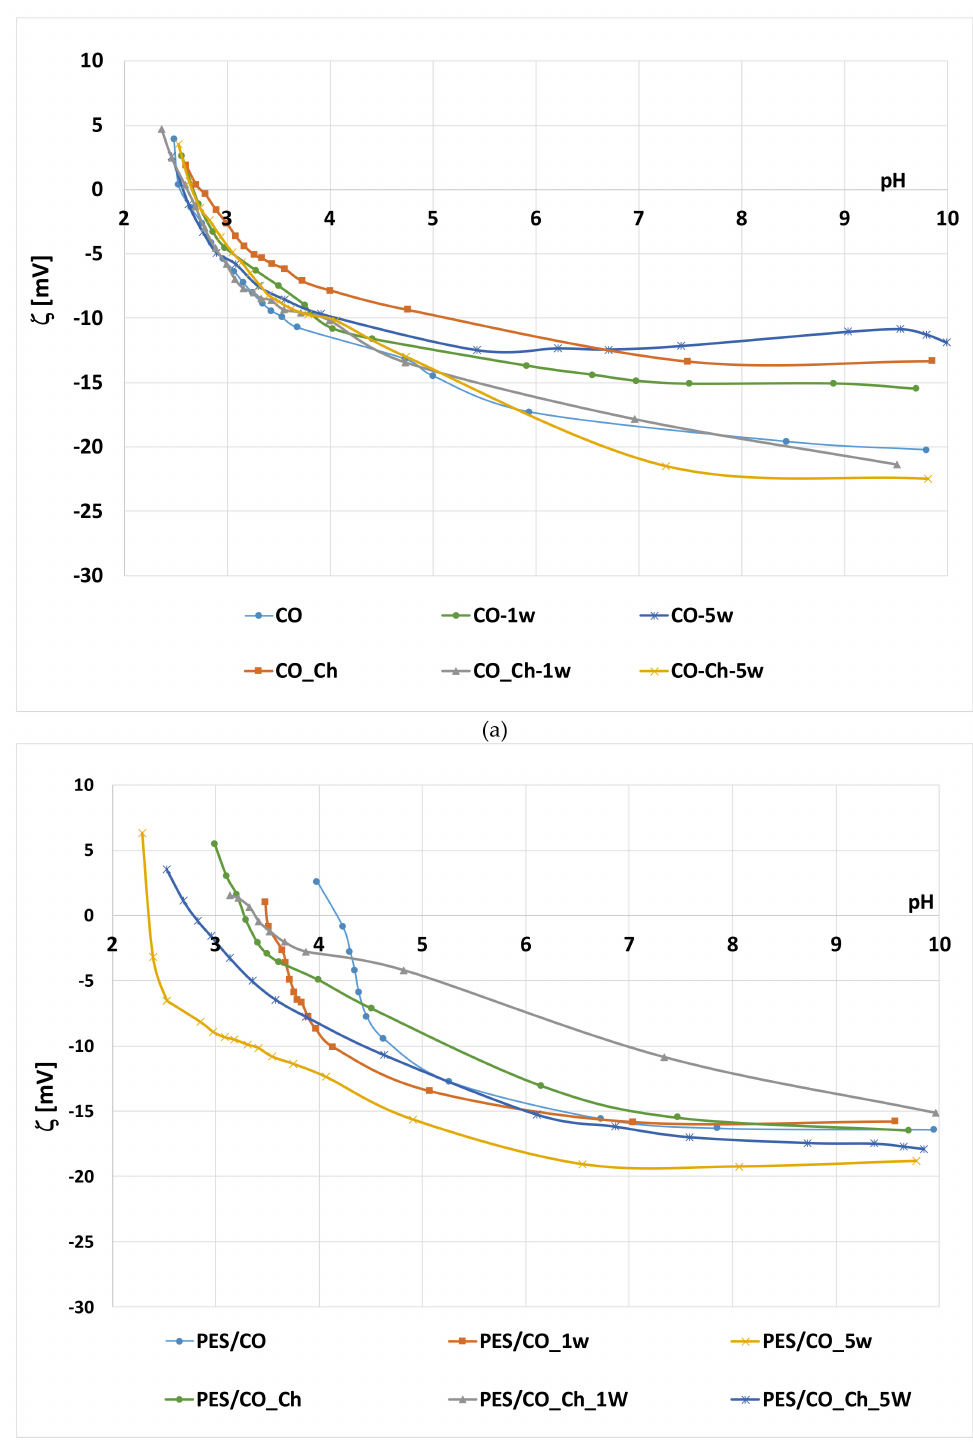
Figure 8. Zeta potential ( ζ ) vs. pH of 0.001 M KCl for ( a ) cotton (CO) and ( b ) polyester / cotton blended (PES / CO)